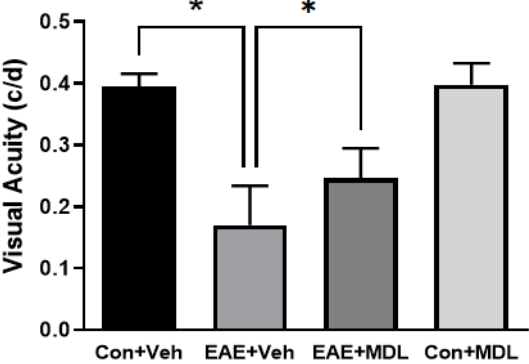
Figure 5. MDL 72527 improved visual acuity in EAE mice. Optokinetic studies show a reduction